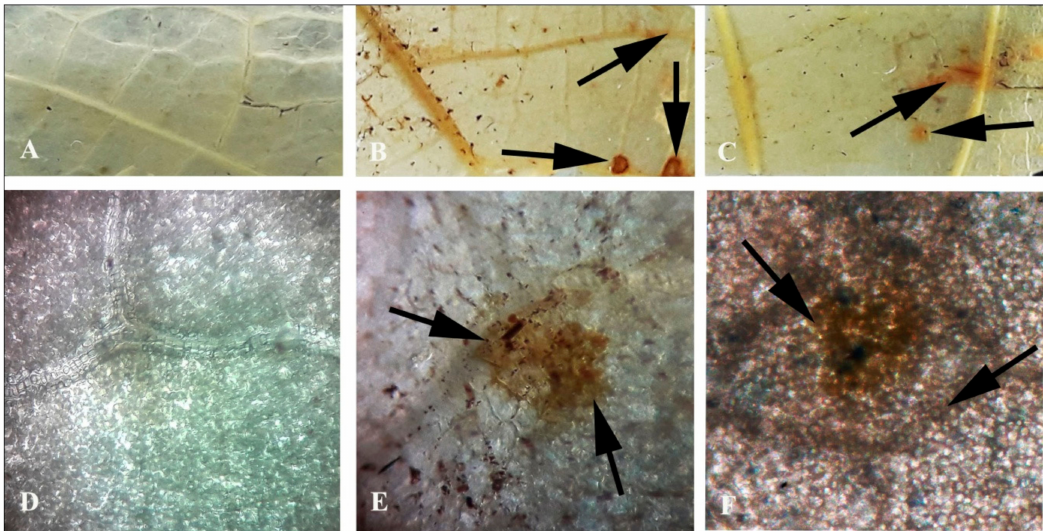
Figure 8. E ff ect of C. gloeosporioides on reactive oxygen species (ROS) generation in pathogen-inoculated bean leaves:( A , D ) 0 dai; ( B , E ) 2 dai; ( C , F ) 4 dai. Arrows indicate the sites of ROS generation.